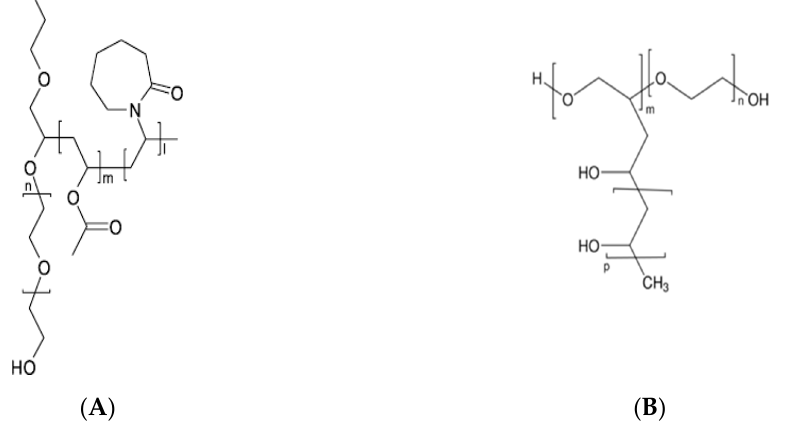
Figure 10. Chemical structure of ( A ) Soluplus ® [79] and ( B ) Kollicoat ® IR [79].